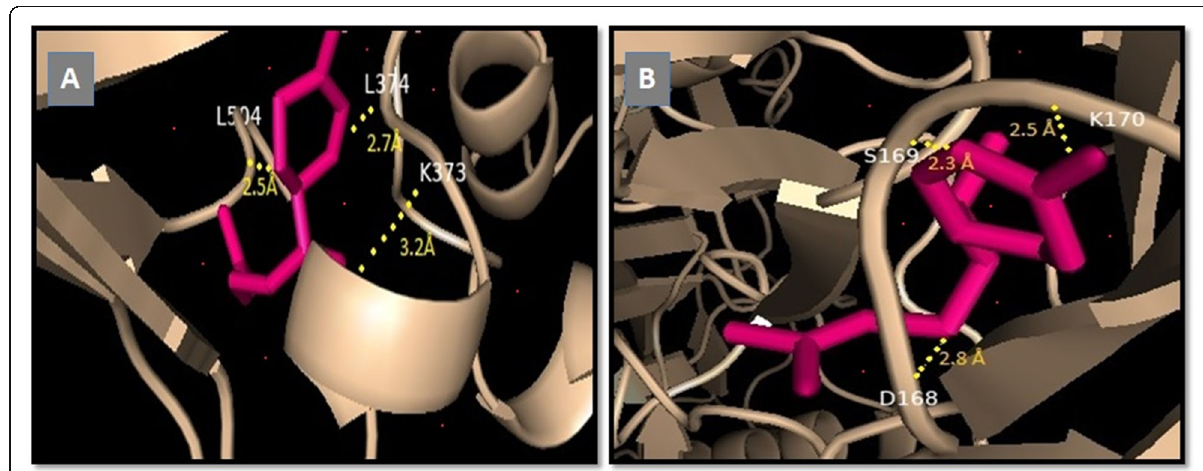
Fig. 4 Docked models. a Spike protein interacting with beta-sesquiphellandrene (Sp-bS): Leu 504, Leu374, and Lys373, makes binding pocket also exhibit 2.5 Å, 2.7 Å, and 3.2 Å hydrogen bonds respectively. b Membrane glycoprotein polyprotein interacting with beta-sesquiphellandrene (MPp- bS): Asp168, Ser169, and Lys170, makes binding pocket also exhibit 2.8 Å, 2.3 Å, and 2.5 Å hydrogen bonds respectively. (Red dots